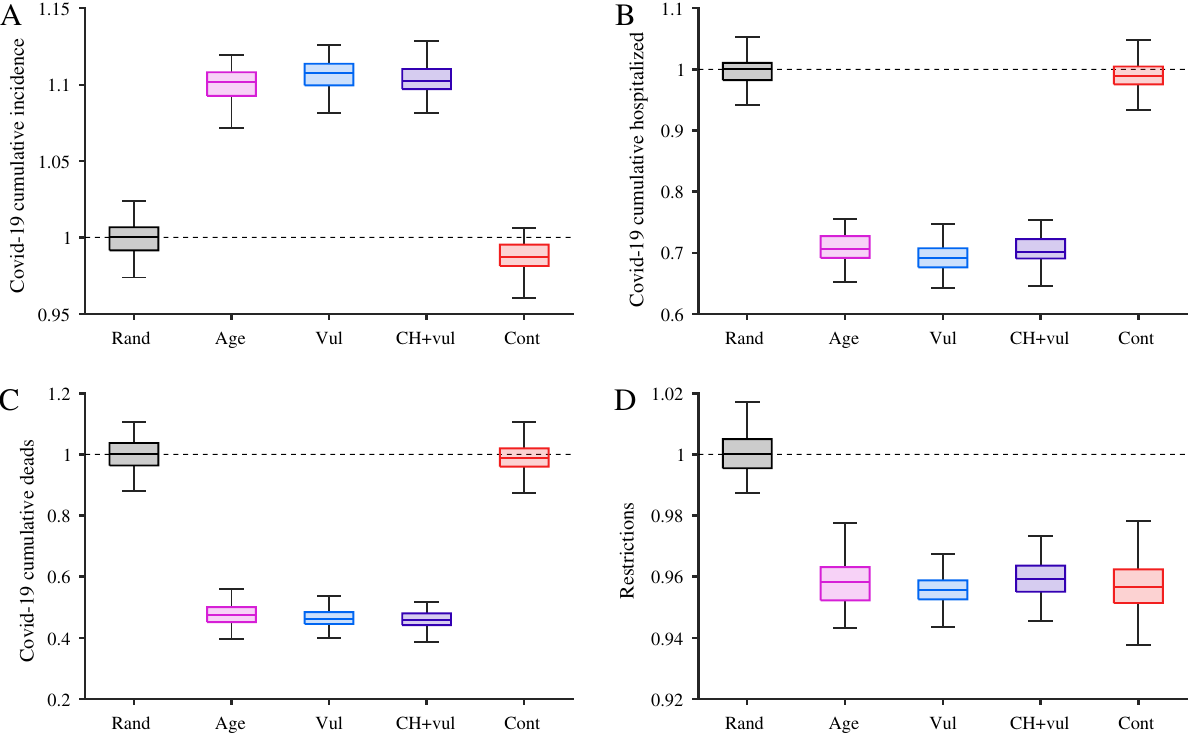
Figure 3. Cumulative incidence of ( A ) infection, ( B ) hospitalisations, and ( C ) mortality, and ( D ) the resulting impact on public health restrictions, according to prioritisation strategy: random (Rand), contagiousness (Cont), age-based (Age), vulnerable (Vul), and vulnerable and care-home residents (CH + Vul). Values are expressed as the ratio between each variable in the vaccination scenario and using random vaccination